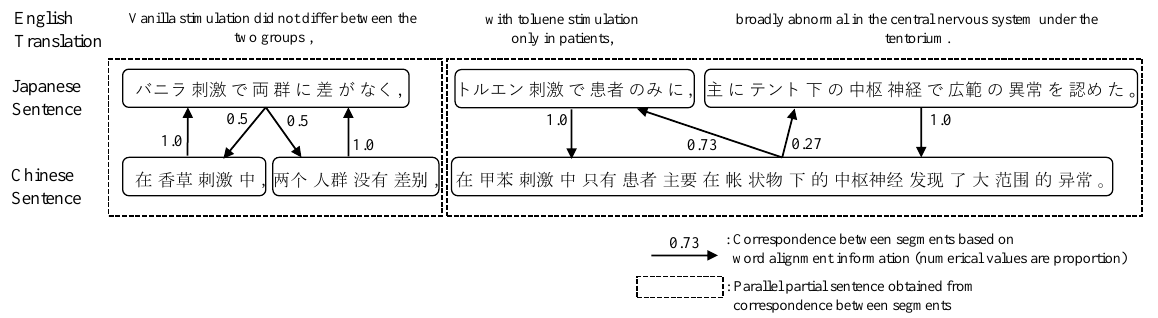
Figure 2. Correspondence rates between segments and parallel partial sentences derived from the